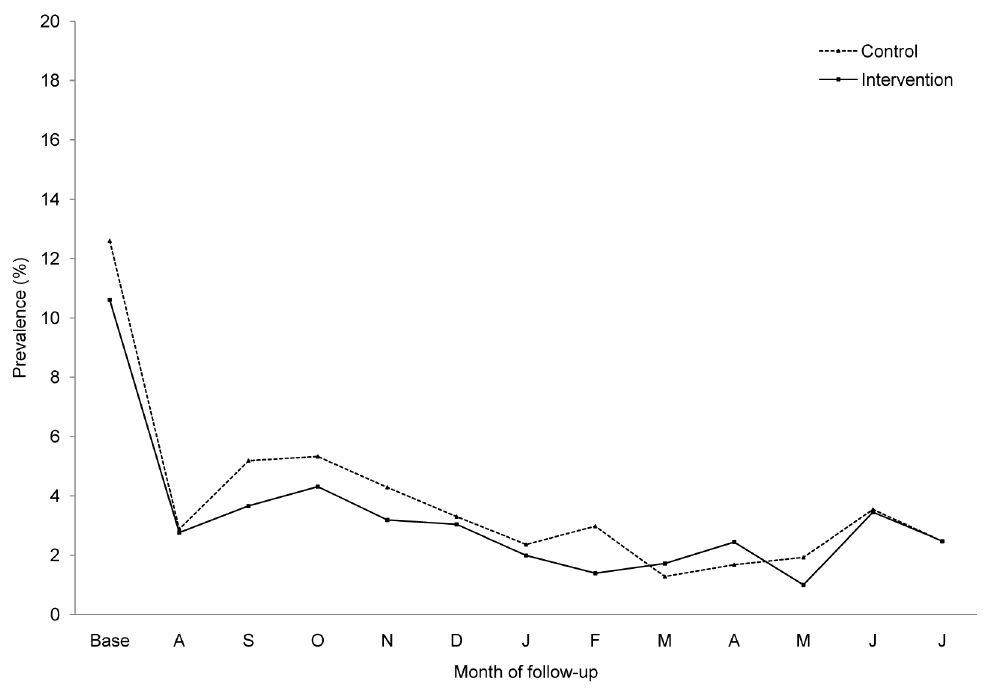
Figure 2. Prevalence of diarrhoea over the course of the study among participants of all ages.